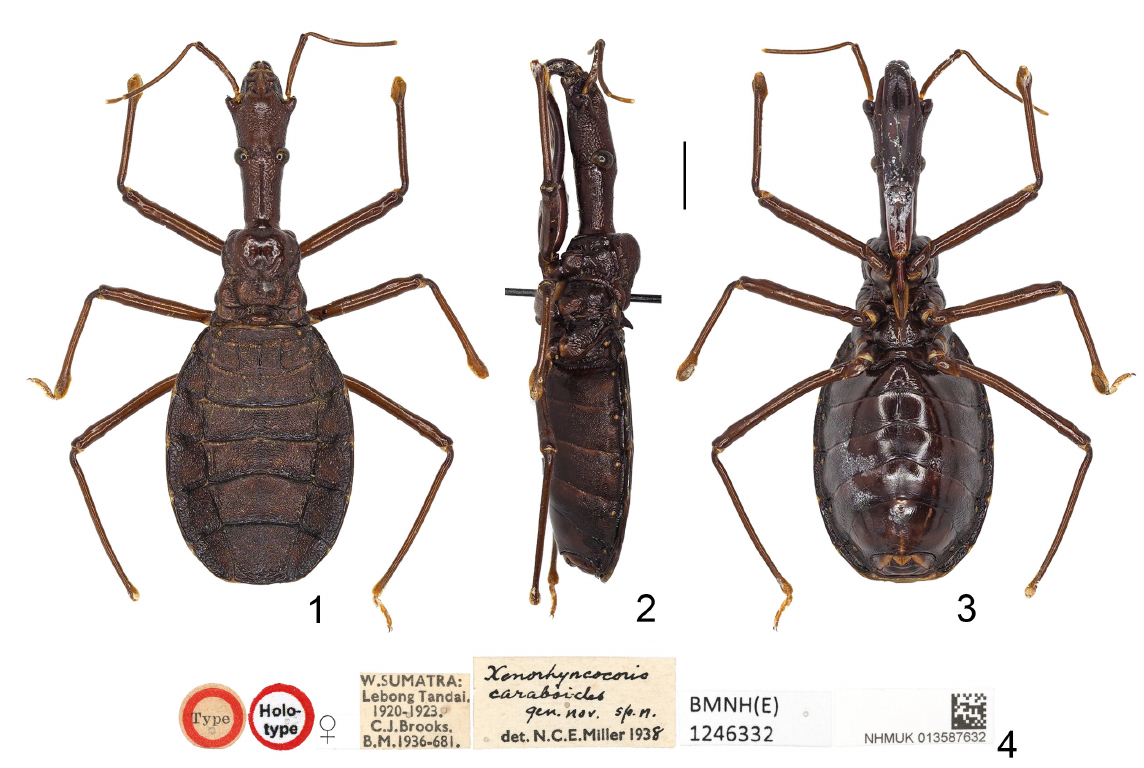
Figs 1–4. Xenorhyncocoris caraboides Miller, 1938, holotype, ♀ (NHMUK 013587632), habitus. 1 . Dorsal view. 2 . Lateral view. 3 . Ventral view. 4 . Labels. Scale bar: 1–3 = 5.00